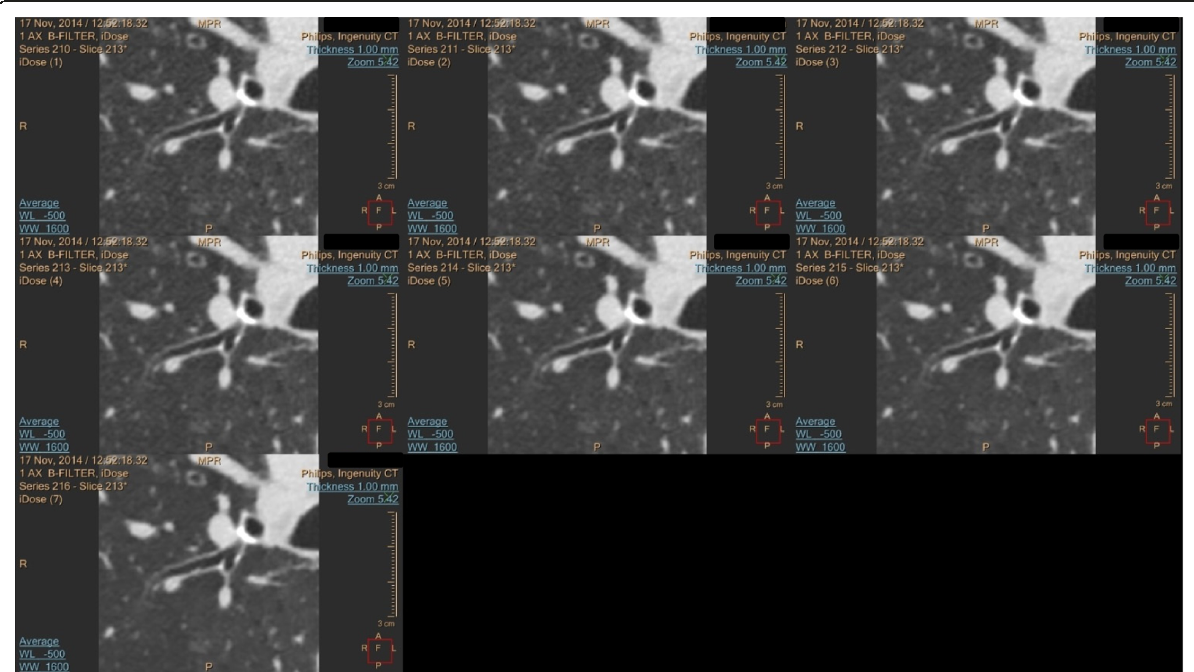
Fig. 1 Magnification of the lung parenchyma in a CT scan with the seven different iDose 4 levels in ISP6: upper row iDose 4 level 1 to 3; middle row: iDose 4 level 4 to 6; bottom: iDose 4 level